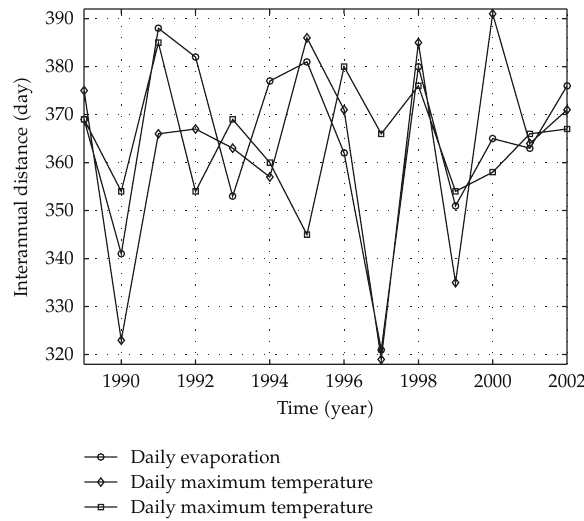
Figure 11: The interannual distances computed from the extracted annual cycles of of three climate signals.